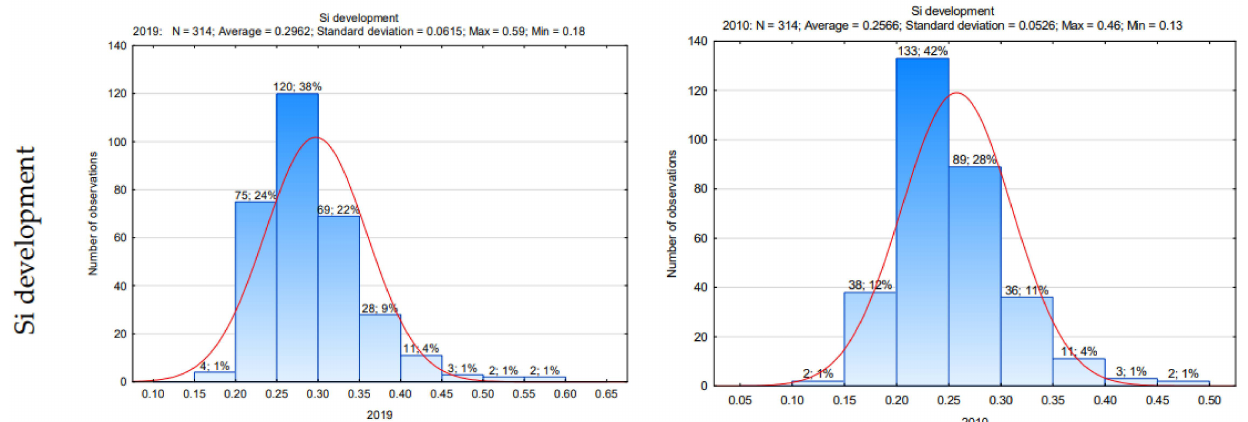
Figure 3. Differentiation of the synthetic financial measure as well as the demographics and labor market of poviats in Poland in 2010 and 2019. Source: study based on BDL CSO data.